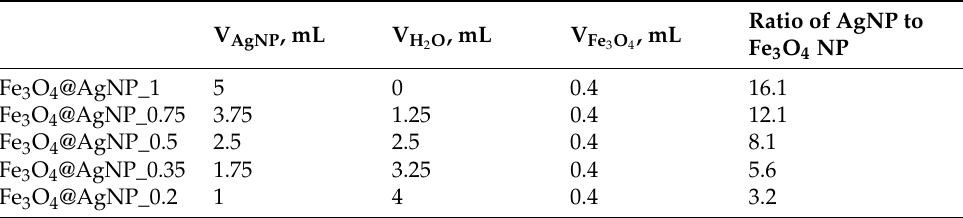
Table 1. AgNP, H 2 O, and Fe 3 O 4 volumes (mL) used in this study to form Fe 3 O 4 @AgNPs with varied silver and magnetite ratio. The ratio of AgNP to Fe 3 O 4 NP is calculated in the last column. Ratio of AgNP to V AgNP , mL V H , mL V Fe , mL Fe 3 O 4 NP 2 O 3 O 4 Fe 3 O 4 @AgNP_1 5 0 0.4